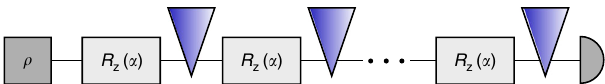
Fig. 1 Schematic representation of the parameter encoding: propagation starts on the left with an initial state ρ and ends on the right with a measurement (semi-circle symbol). The encoding through linear precession R z ( α ) about the z -axis by an angle α is periodically disrupted through parameter independent, non-linear, controlled kicks (blue triangles) that can render the (associated circular area ~1/ j in phase space). They remain coherent states under the action of U α (0), i.e., just get rotated, ϕ 7! ϕ þ α . For the KT, the parameter encoding of α in the quantum state breaks with the standard encoding scheme (initial state preparation, parameter-dependent precession, measure- ment) by periodically disrupting the coding evolution with parameter-independent kicks that generate chaotic behavior (see Fig. 1).